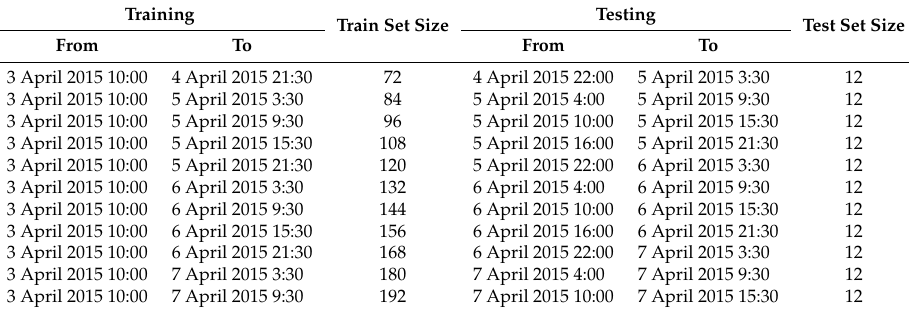
Table 2. Dataset partitions for evaluating classifiers.